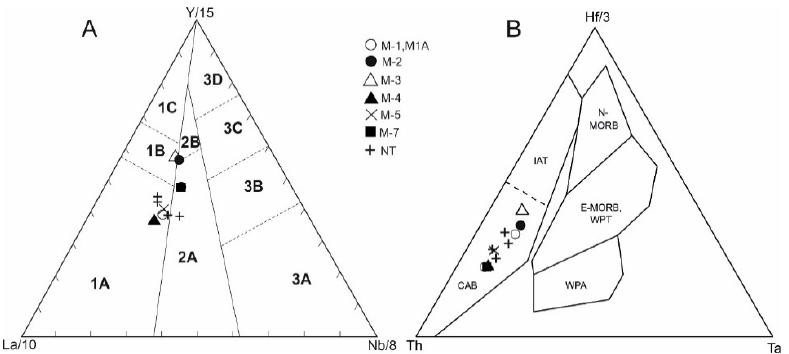
Figure 10. ( A ) The La-Y-Nb: discrimination diagram for basalts [58] Field 1—volcanic arc basalts, field 2—continental basalts and field 3—oceanic basalts. The subdivision of the fields as follows: 1A = calc-alkaline basalts, 1C = volcanic arc tholeiites, 1B = overlap is between 1A and 1C, 2A = conti- nental basalts, 2B = back-are basin basalts, 3A = alkaline basalts from intercontinental rift, 3B, 3C = E-type MORB (enriched MORB), 3D = N type– MORB; B) The Th-Hf-Ta: discrimination diagram for basalts [57]. ( B ) The field are defined as follows: N-MORB (normal Mid Ocean Ridge Basalt), E- MORB and WPT (within-plate tholeiites), WPA (within-plate alkali basalts), IAT (Island arc tholeiites, Hf/Th > 3.0) and CAB (calc-alkali basalts; Hf/Th < 3.0). The broken lines indicate transi- tional zones between basalt types. Sample M-1—M7 from Table 7, NT—analyses of paleobasalts from Vozár et al. [61].